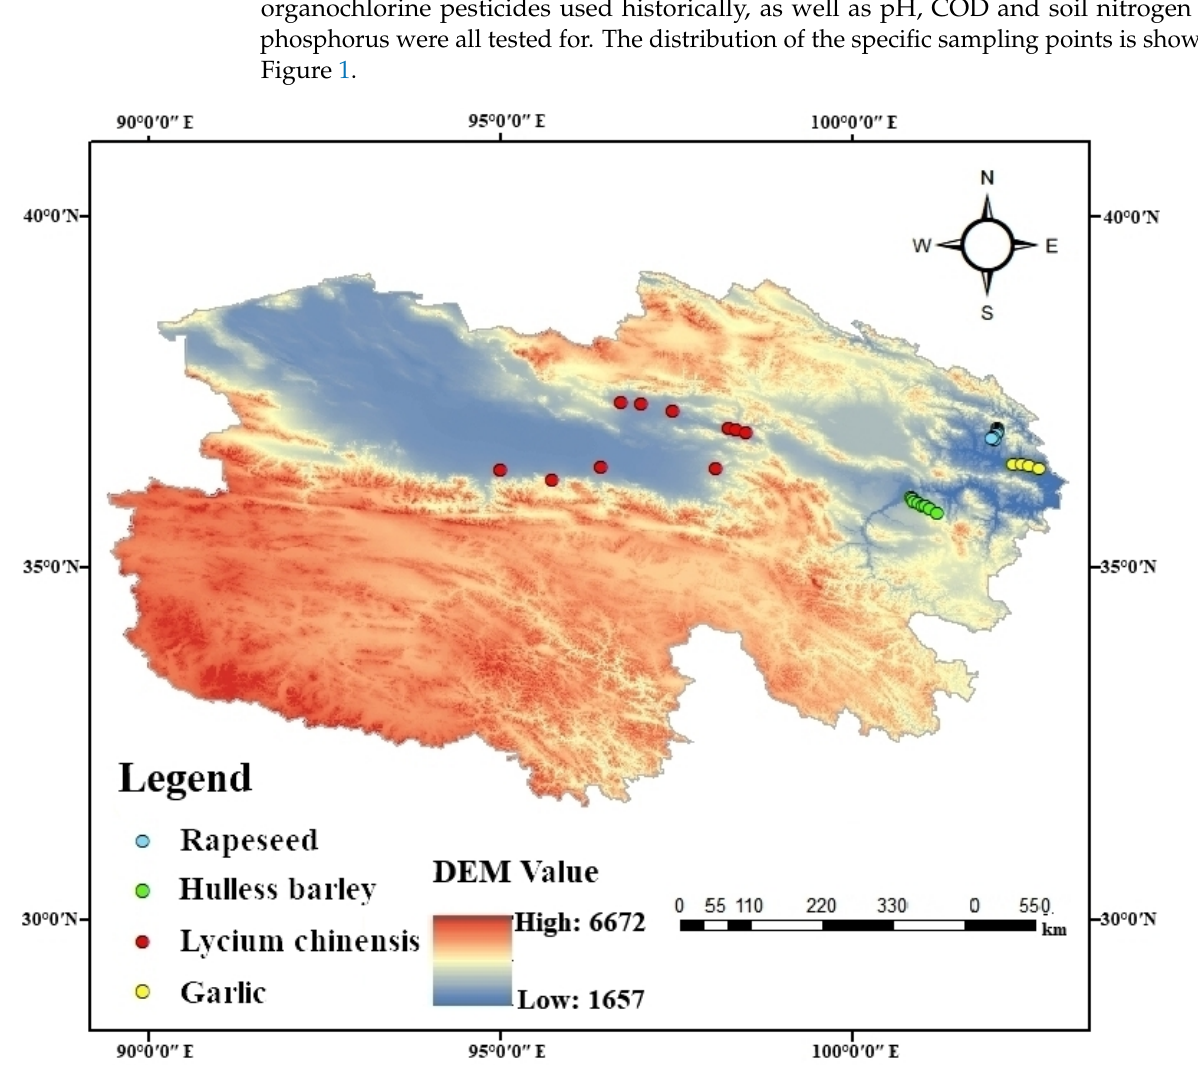
Figure 1. Schematic diagram of the sampling points for surface water in four typical crop-producing areas.